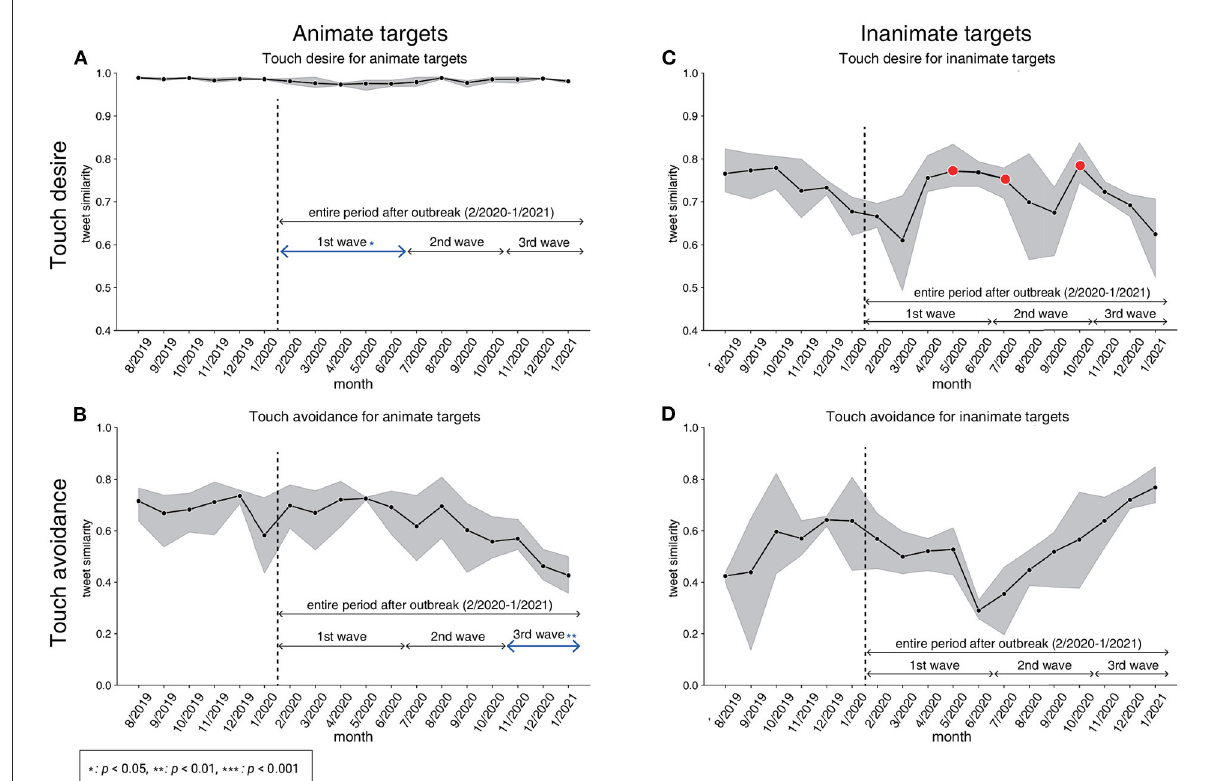
FIGURE5 Variation of tweet similarity and the results of the DID and the event study. Results on touch desire (A) and touch avoidance (B) for animate targets. Results on touch desire (C) and touch avoidance (D) for inanimate targets. The difference of the tweet similarity before and after the outbreak was compared to the control period (i.e., corresponding periods in previous years). Lines represent the tweet similarity with shaded areas showing 95% CI. The vertical dashed line indicates the timing of the outbreak. In addition, the effect of the COVID-19 outbreak and the 1st–3rd waves are indicated. Full results are presented in Supplementary Table 2. Red-colored arrows represent that the similarity increased significantly during those periods. Blue-colored arrows represent that the similarity decreased significantly during those periods. Also, red-, and blue-colored points denote the results of the event study analysis. Red-colored points represent that the difference in the tweet similarity between the focused month after the COVID-19 outbreak and the other 6 months just before the COVID-19 outbreak increased significantly relative to those in past years (2013–2018). Blue-colored points represent that the difference in the tweet similarity between the focused month after the COVID-19 outbreak and the other 6 months just before the COVID-19 outbreak decreased significantly relative to those in past years (2013–2018). The increase and decrease in the tweet similarity were not significant in any month in the period before the COVID-19 outbreak, which supports the assumption for the parallel